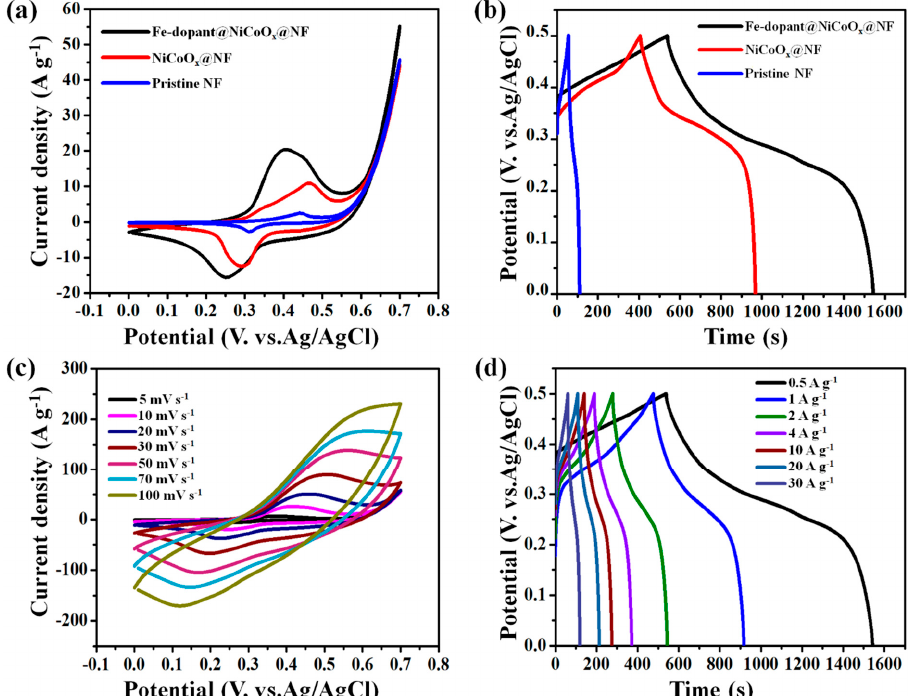
Figure 6. Electrochemical characteristic of the as-synthesized electrodes in a three-electrode system: ( a ) CV curves for NF, NiCoO x @NF nanowires, Fe-dopant@NiCoO x @NF nanoneedle composite electrodes at 10 mV·s − 1 ; ( b ) GCD plots for NF, NiCoO x @NF nanowires, and Fe-dopant@NiCoO x @NF nanoneedles at 0.5 A g − 1 ; ( c ) full CV tests for Fe-dopant@NiCoO x @NF nanoneedle composite elec- trodes at several applied scan rates; and ( d ) full GCD tests for Fe-dopant@NiCoO x @NF nanoneedle composite electrodes at several applied currents.